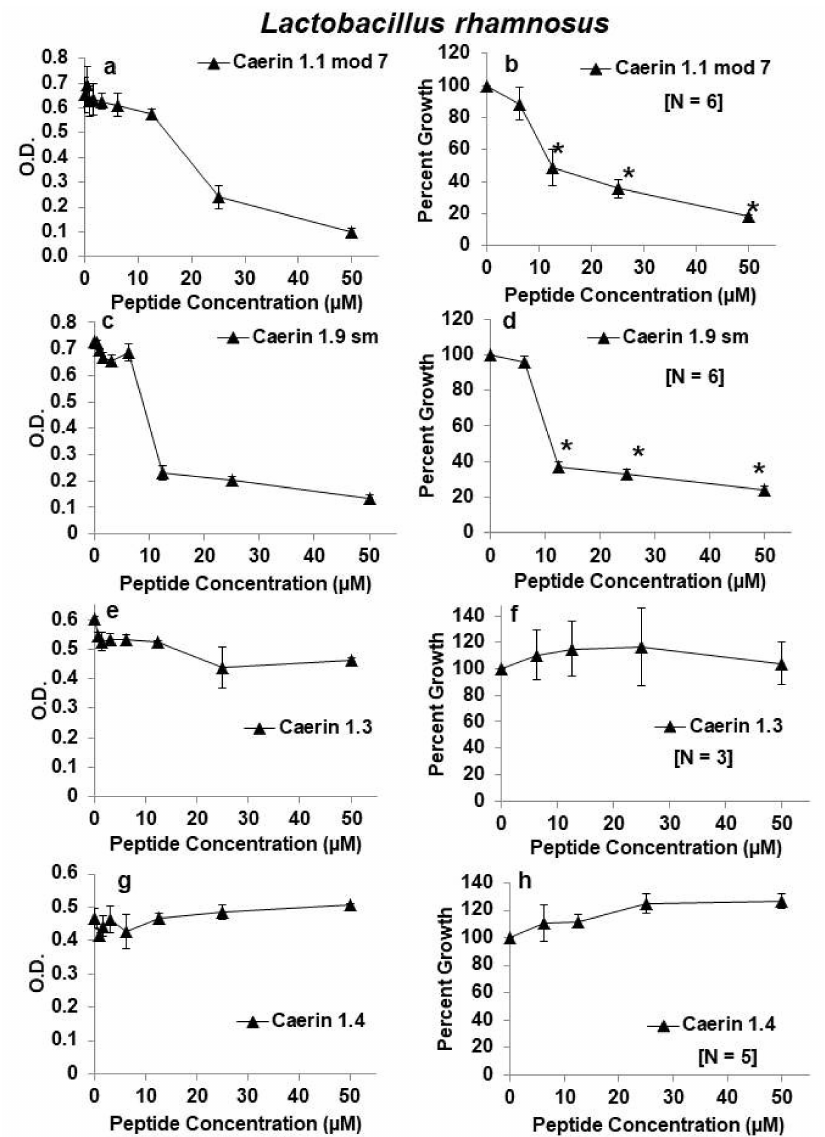
Figure 2. E ff ects of caerin 1 peptides on growth of Lactobacillus rhamnosus. ( a , b ) Caerin 1.1 mod 7; ( c , d ) Caerin 1.9 sm; ( e , f ) Caerin 1.3; ( g , h ) Caerin 1.4. Panels on the left show growth as changes in optical density (O.D.) at 630 nm for one representative experiment testing the peptides at increasing 2-fold concentrations from 0.4 or 0.8 to 50 µ M. Panels on the right show the average as percent growth in comparison with the positive (no peptide) control set at 100% for replicate experiments for the range of concentrations from 6.25–50 µ M. The number of replicate experiments for each peptide is shown in brackets within the panel. * Significantly reduced growth in comparison with the positive control, p < 0.01 by one-way ANOVA with Tukey’s post hoc